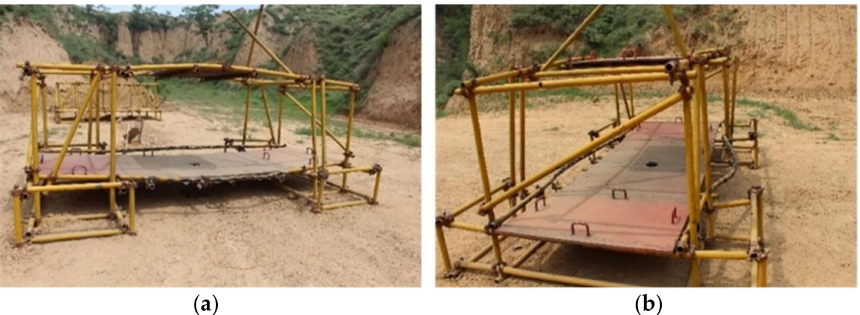
Figure 5. Damage to composite steel structure after the explosion without explosion height. ( a ) Front view; ( b ) Side